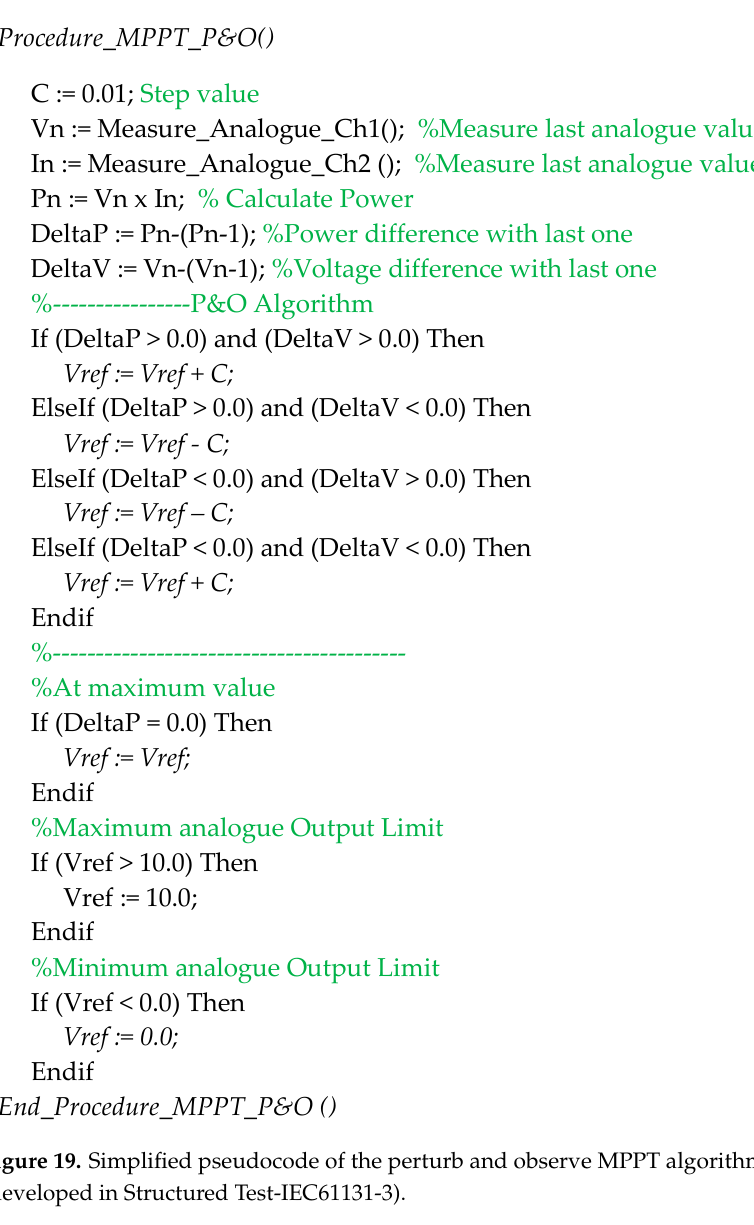
Figure 19. Simplified pseudocode of the perturb and observe MPPT algorithm running in the PLC (developed in Structured Test-IEC61131-3).